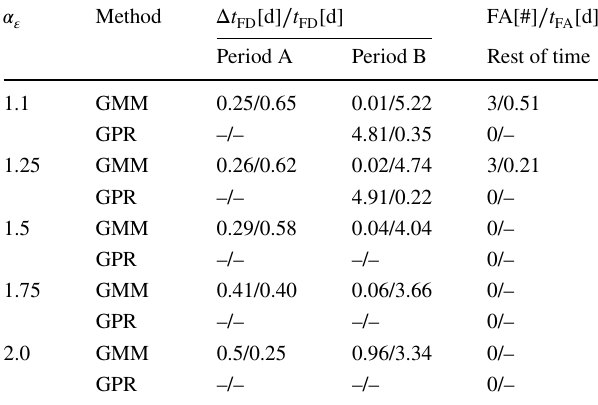
Table 1 Summary of GMM and GPR performance for different 𝛼 𝜀 𝛼 𝜀